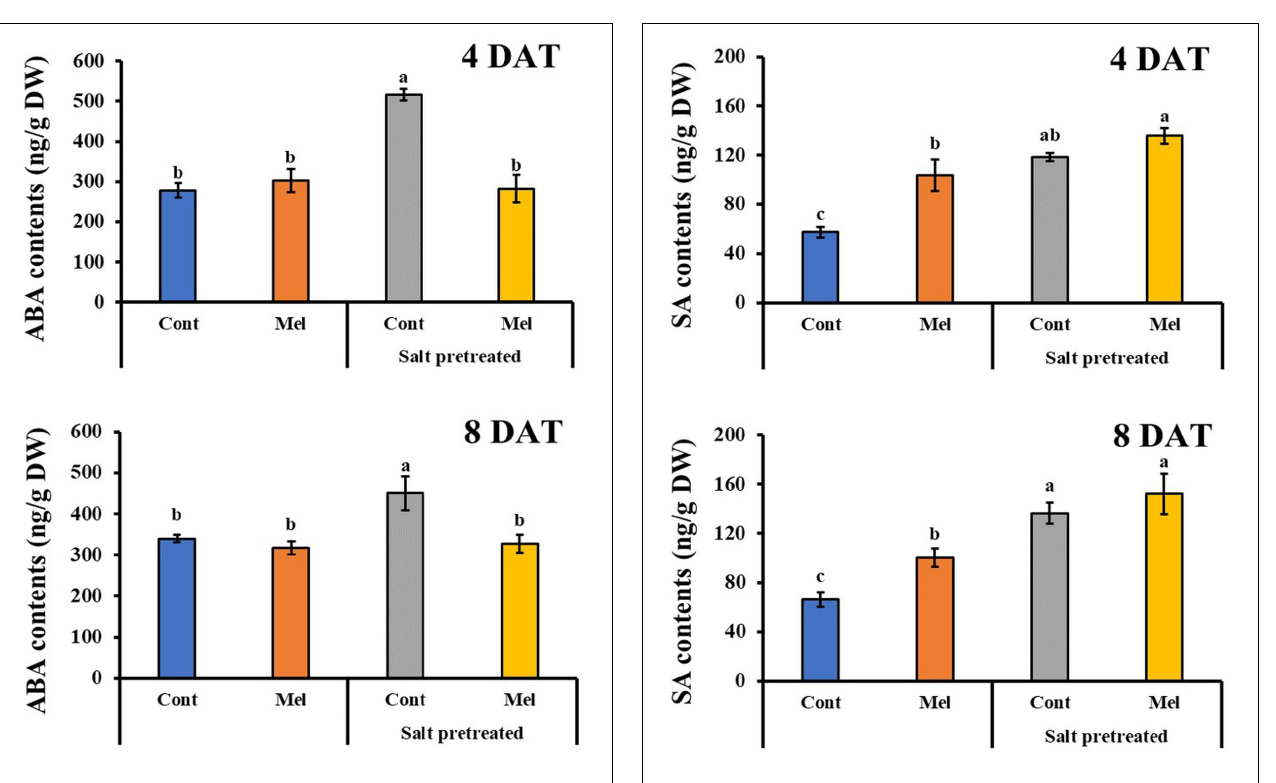
FIGURE 8 | Effect of melatonin with/without salt stress on SA content in green mustard seedlings. The results were calculated from data for 4 (4DAT) and 8 (8DAT) days. Treatment: control + water, control + 1 µ M melatonin, 150 mM salt pre-treatment + water, 150 mM salt pre-treatment + 1 µ M melatonin. Values show the means ± SE ( n = 3). Letters represent significant differences at p < 0.05 in accordance with Duncan’s multiple range